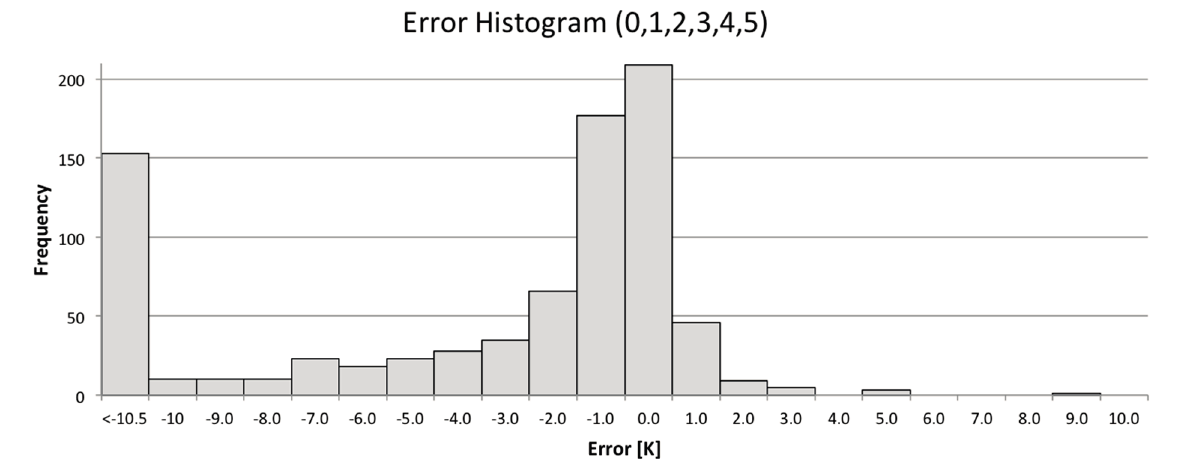
Figure 11. Histogram of errors for all Landsat 5 scenes in validation data set.